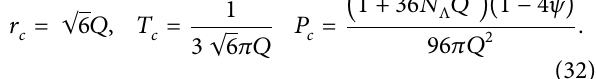
= − 1.03 , 휉 = 2.1 , 푄 = 0.4 , and 푁 𝑝 , 푇 ) and terminates at (푃 , 푇 ) corresponds to the co-existence line of VdW-like SBH/LBH phase transition. 푐2 푐2 𝜏 𝜏 , 푇 ) and terminates at (푃 , 푇 ) denotes the coexistence line of small and intermediate black holes 𝑧 𝑧 𝜏 𝜏